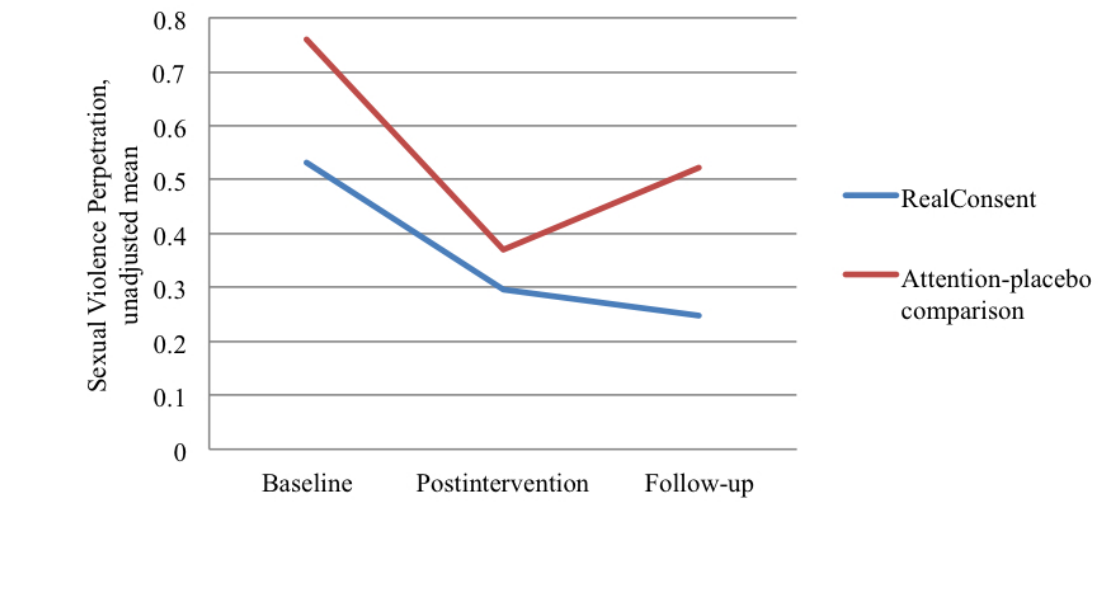
Figure 3. Unadjusted means for sexual violence perpetration across 3 time points for RealConsent and attention-placebo comparison